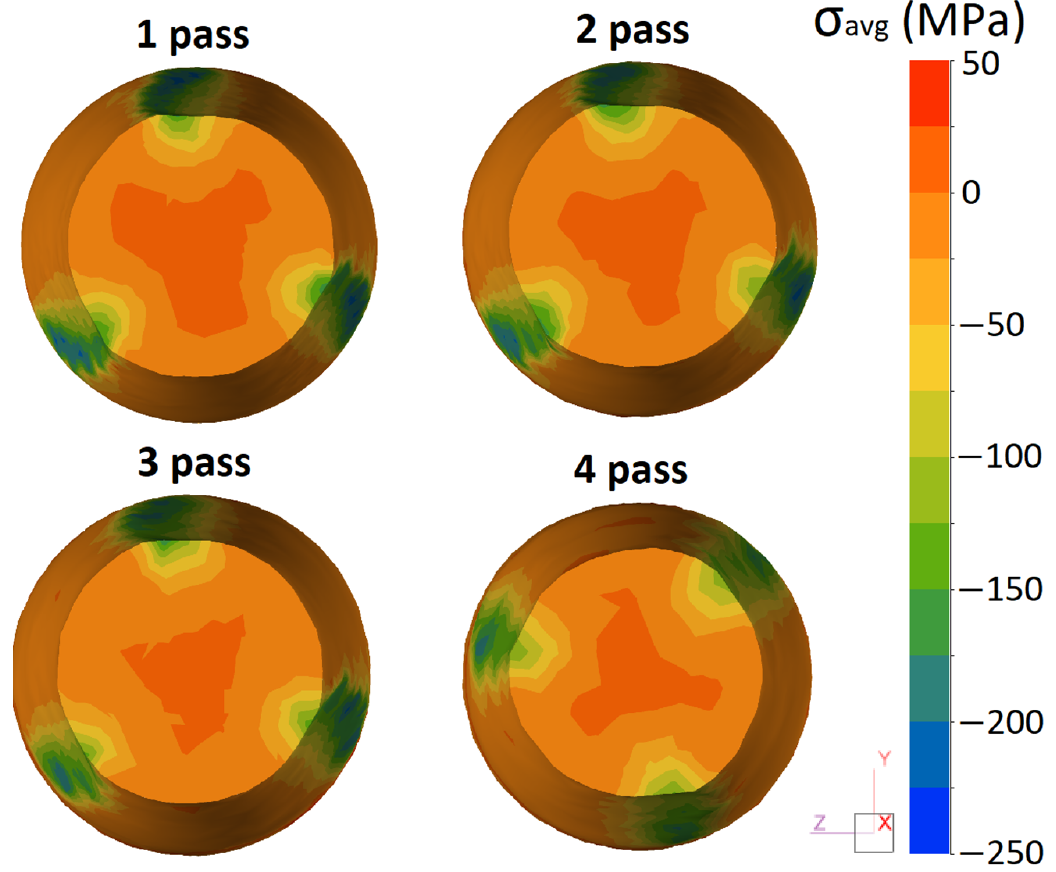
Figure 6. Distribution of average stresses over the cross-section of the rod in each pass (cross-section of roll pinch).